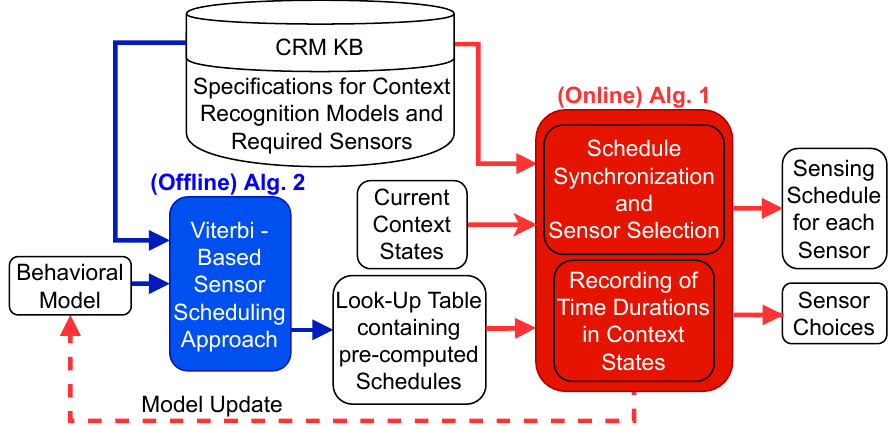
Figure 5. The proposed holistic optimization approach is split into two stages: an online stage (red) which determines the best combinations of sensors and their sensing schedules obtained directly from the LUT according to Algorithm 1, and an offline stage (blue) which provides the best sensing schedule for a particular context state and a group of sensors and stores them in a look-up table (LUT) according to Algorithm